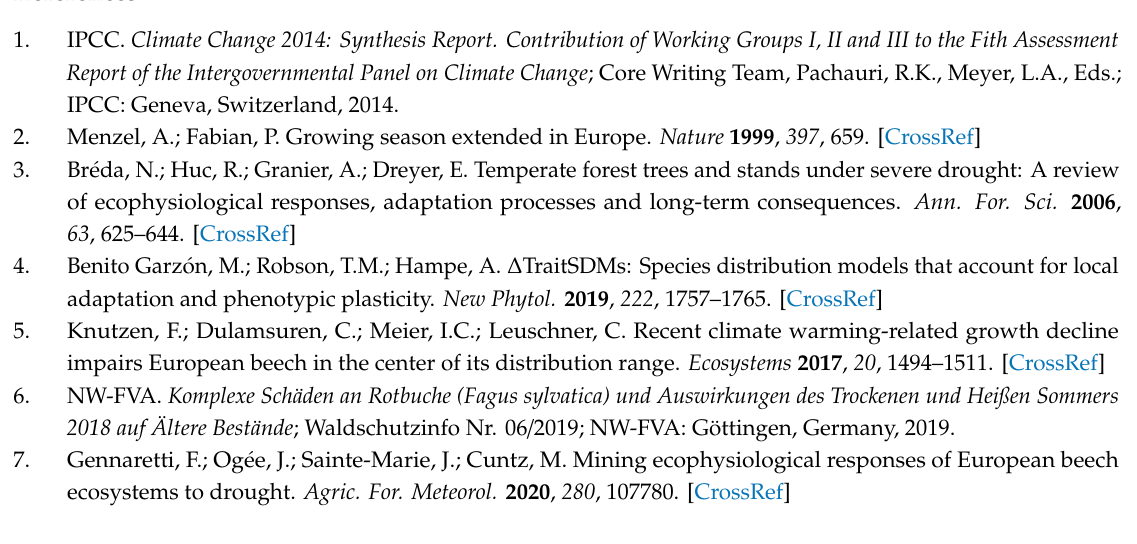
Table S1: overview of climate variables and their correlation with environmental principal components (PCs), Table S2: coe ffi cient of variation (CV) of the populations for plant height increment in the di ff erent regions, Figure S1: boxplots of plant height for the population (a) SEW, (b) HEW, and (c) AEW in the di ff erent years, and (d) interaction plot of mean plant height in 2015 of the di ff erent populations in the three study regions (please note that A5_09 was removed from AEW in Figure S1(d), since it is based on approx. half the sample size of the other populations and not significantly di ff erent to most populations (see Figure S1(a–c) for details), but would create the impression of superior plant height in the figure). (Populations from the SEW region: S5 and S9; from HEW: H10, H10_09, and H6; from AEW: A5, A5_09, and A8. For the populations H10 and A5, seeds from 2009 were also available for raising seedlings and are named H10_09 and A5_09,